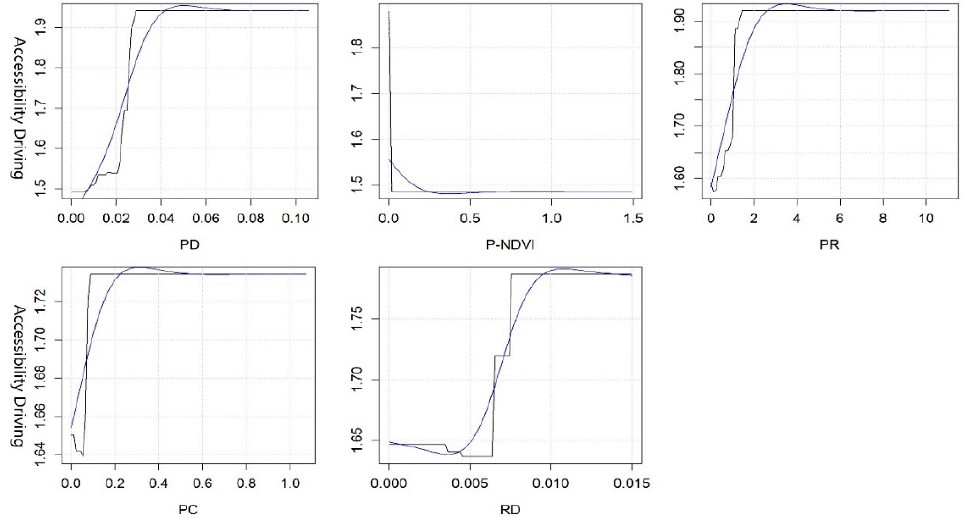
Figure 5. Nonlinear effects of various variables on the accessibility of PGSs by driving.